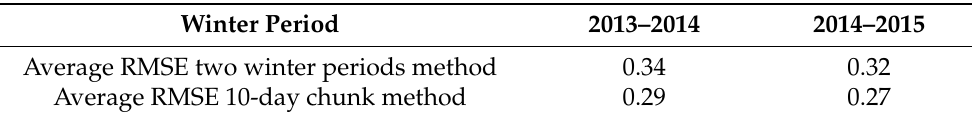
Table 2. Splitting the training and test set into two winter periods compared to using the 10-day chunk method and only including the same periods when averaging the RMSE. RMSE between forecasted and observed hourly production